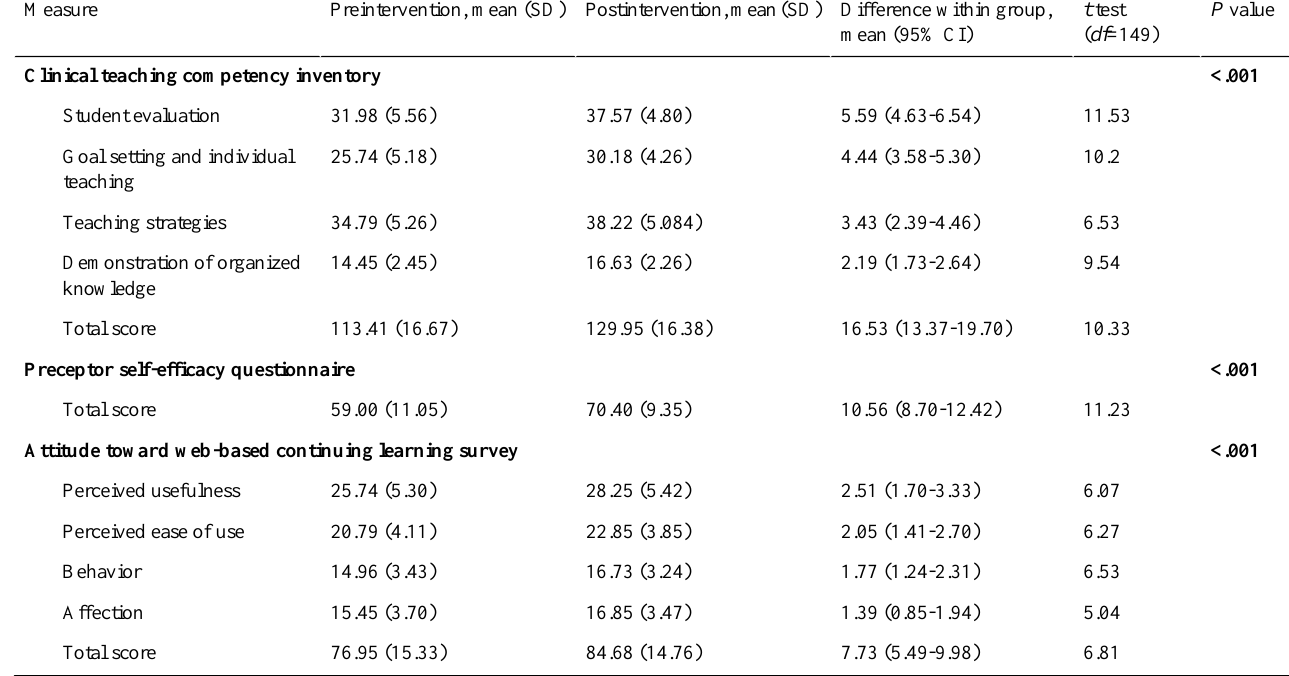
Table 3. Mean scores for the clinical teaching competence inventory, preceptor self-efficacy questionnaire, and attitudes toward a web-based continuing learning survey, before and after the intervention